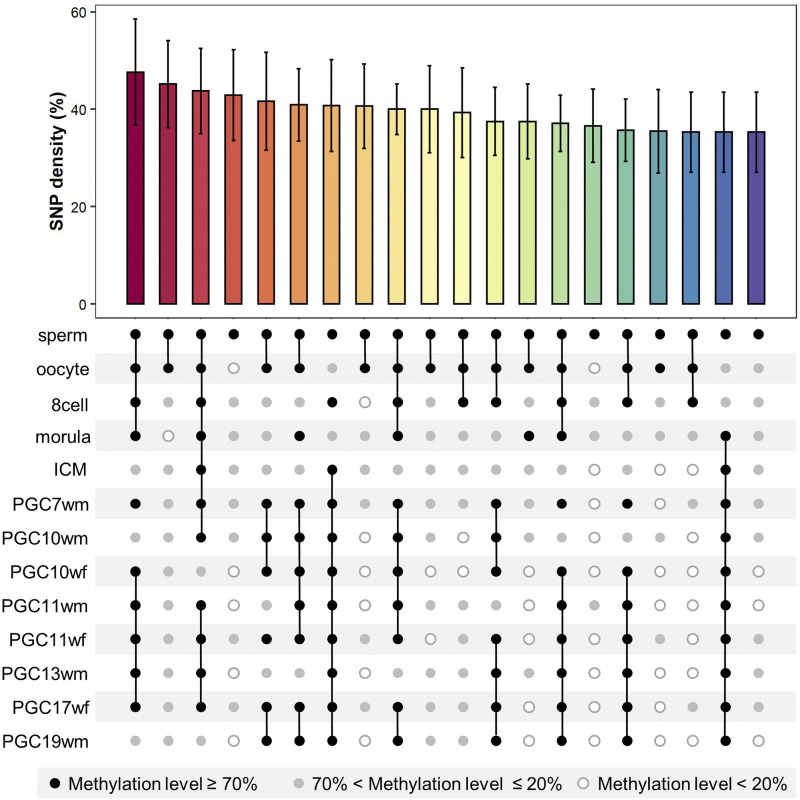
The most mutable methylation dynamic patterns during germline development. The top histogram shows the top 20 mutation rate of all methylation patterns at a single site, computed by SNP density. The bottom plot shows the methylation dynamics of one common site in 13 stages. The black dot represents that the site is highly methylated (methylation level ≥ 70%), the white dot represents unmethylated (methylation level < 20%) and the gray dot represents methylation level in between.